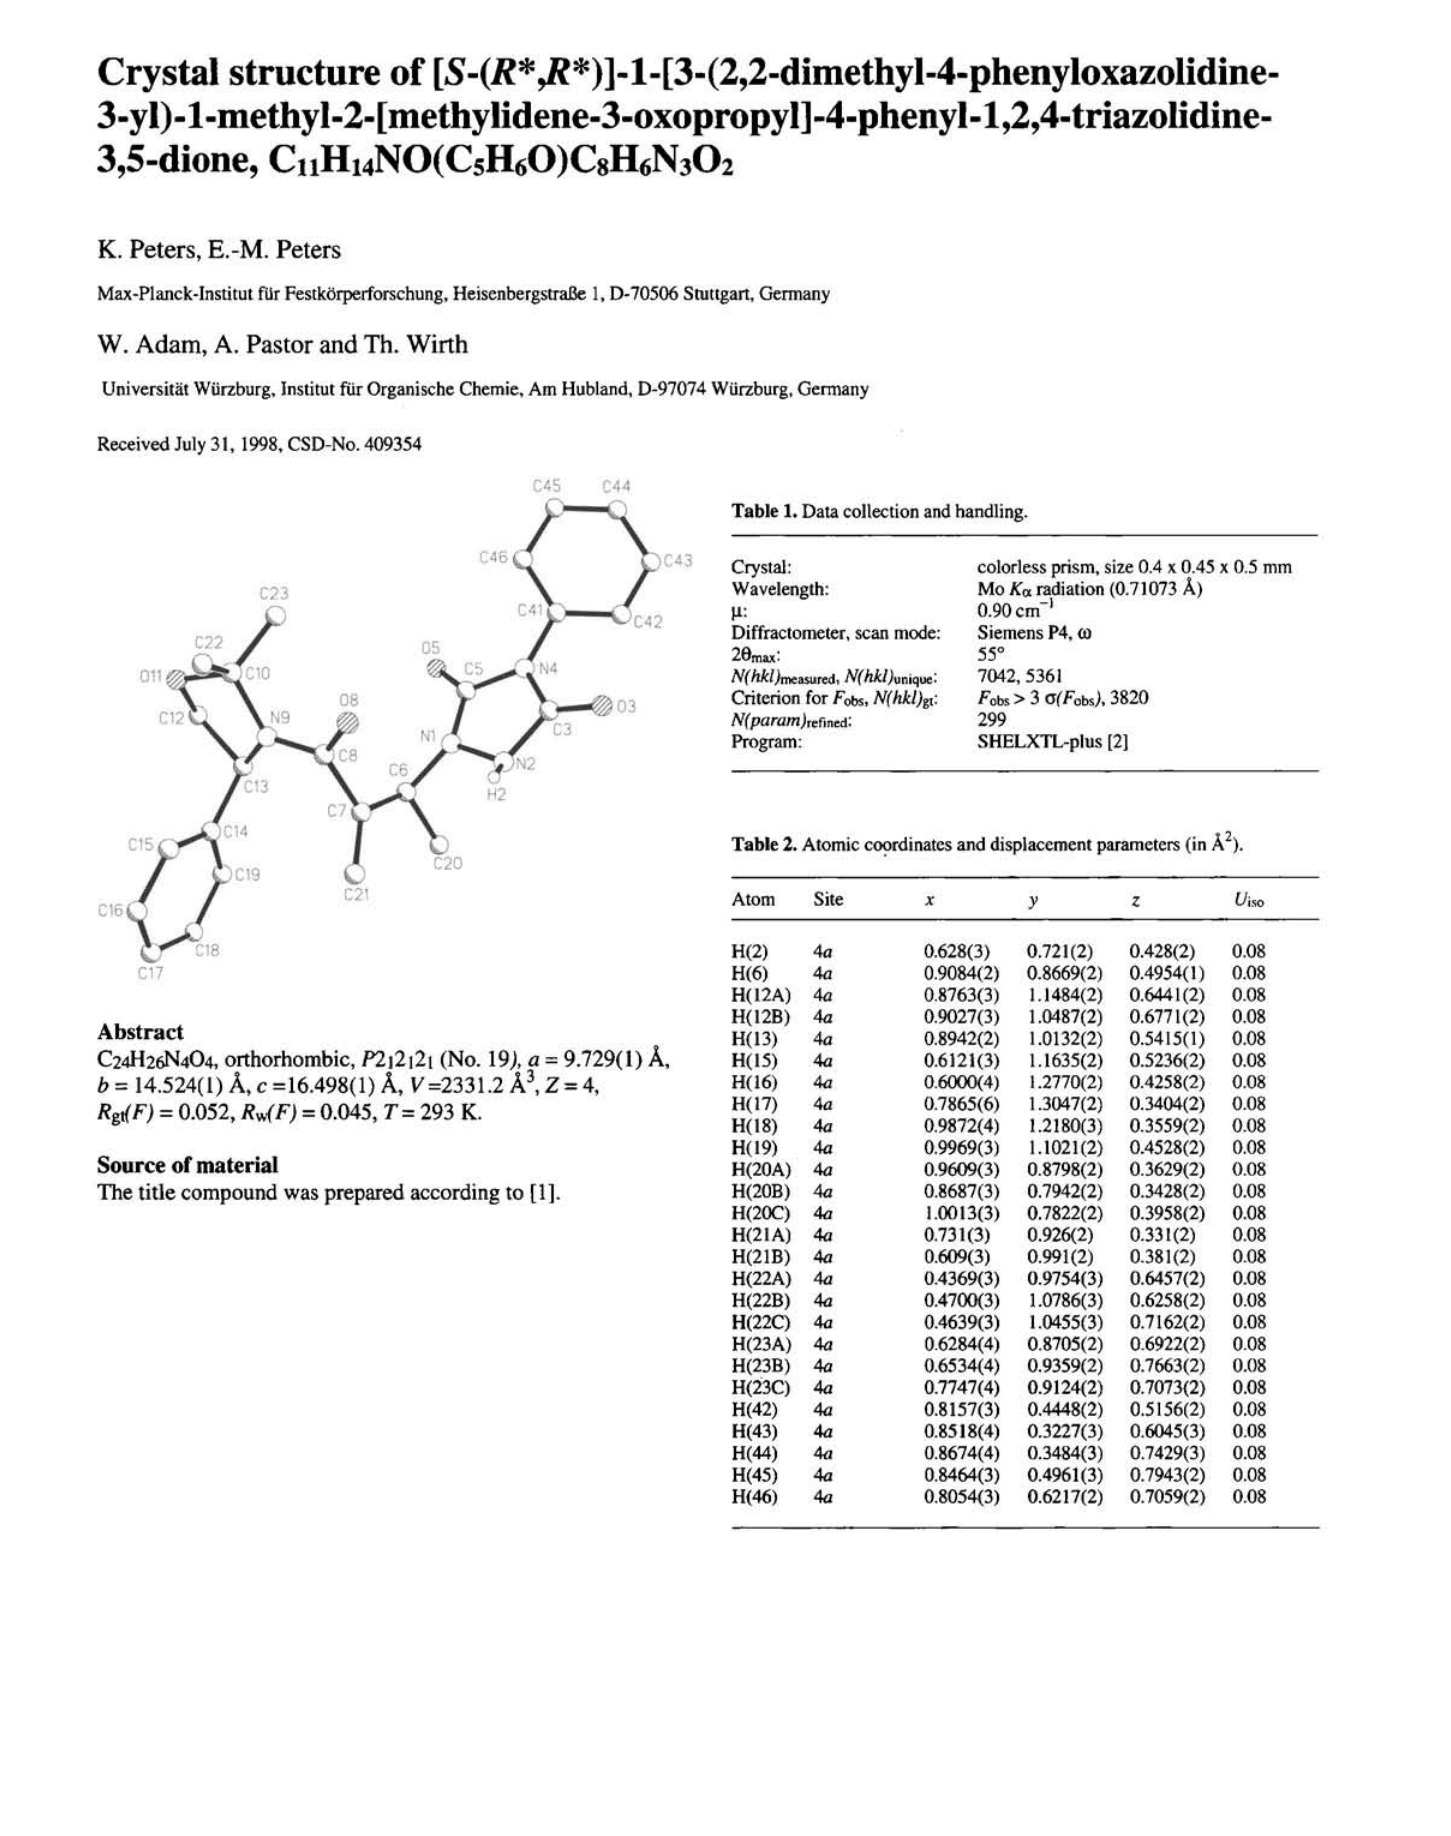
Table 1. Data collection and handling. Crystal: